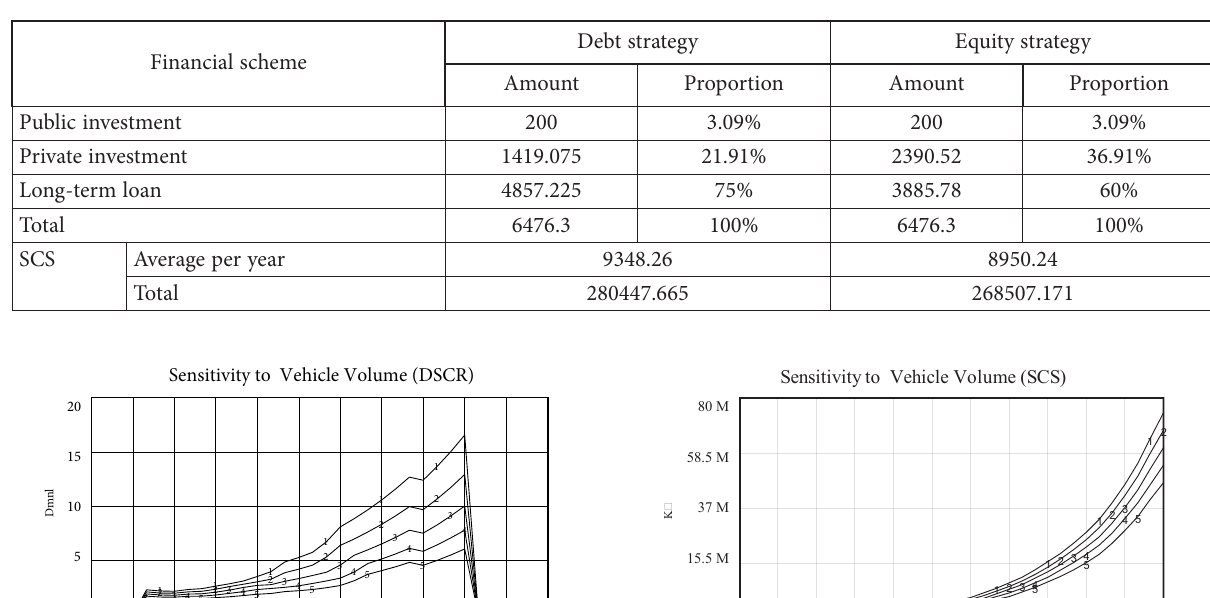
Table 3. Simulation results for SCS influenced by two financing strategies (Unit: RMB million)